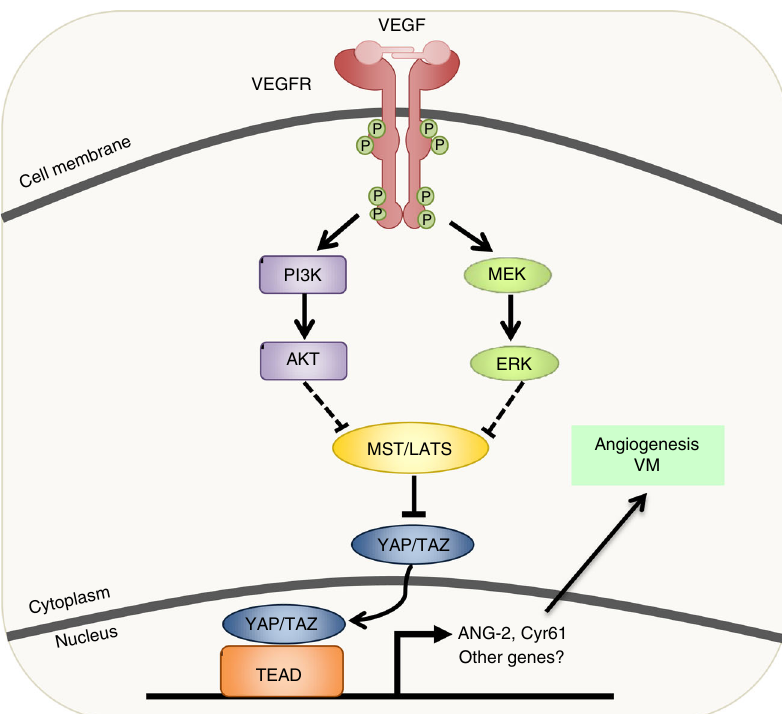
Fig. 7 Model for VEGFR and Hippo signaling in angiogenesis/VM. When VEGF binds to its receptor, VEGFR, signaling through PI3K and MAPK is initiated. This leads to the inhibition of MST/LATS and subsequent activation of YAP/TAZ. YAP and TAZ induce ANG-2 and CYR61 expression, leading to enhanced angiogenesis and vasculogenic mimicry in endothelial and tumor cell lines,